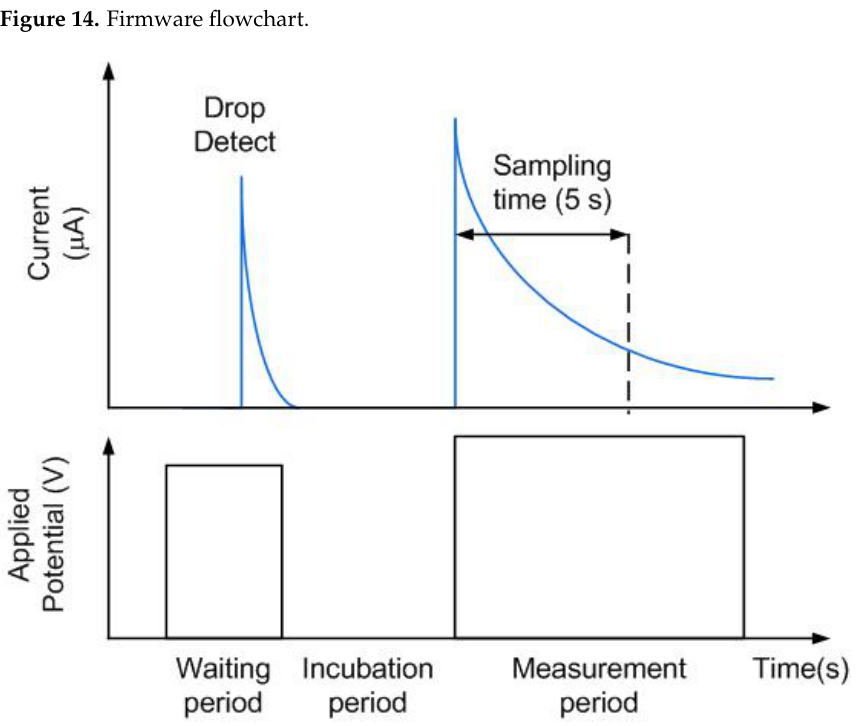
Figure 14. Firmware flowchart.